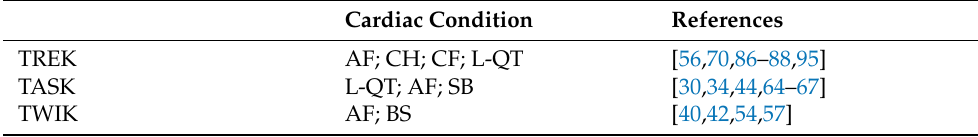
Table 1. Established relationships between K2P channels and adverse cardiac conditions. Cardiac